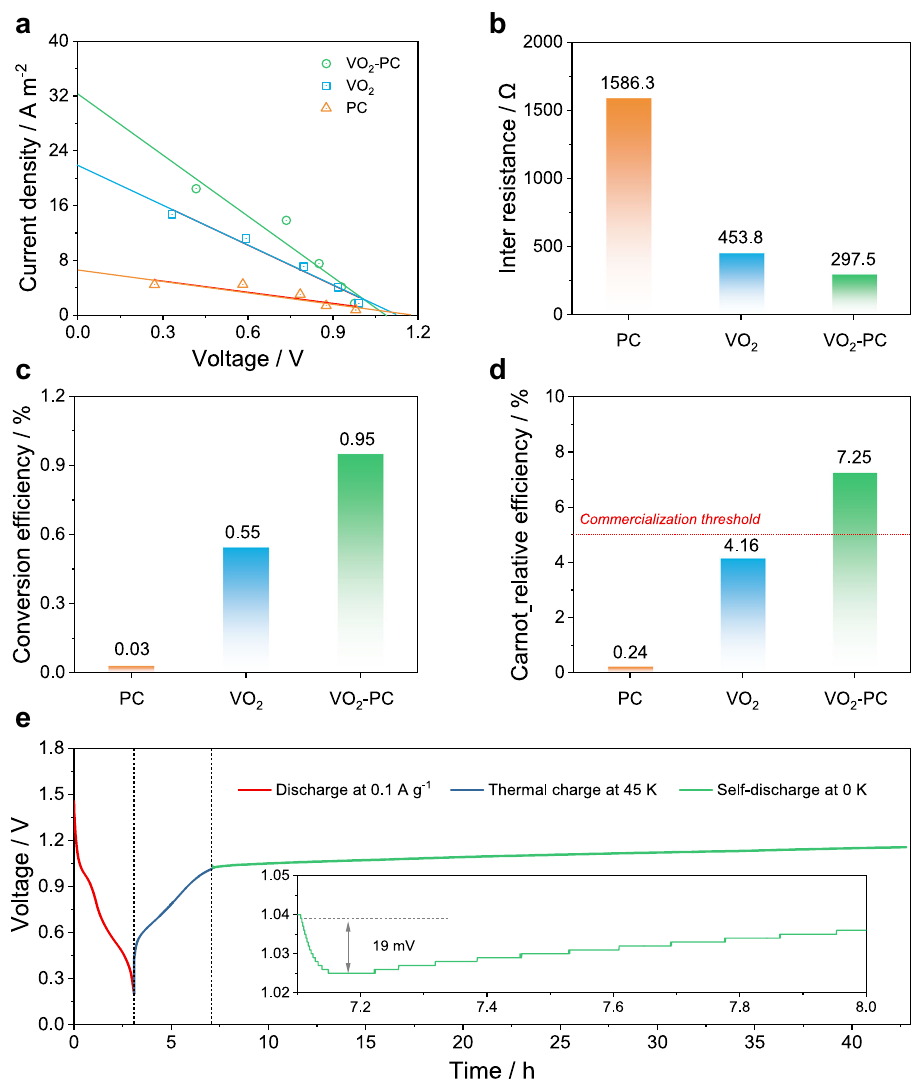
Fig. 3 Heat-to-electricity conversion of ZTCCs. a Current – voltage plot, b inter resistance, c conversion ef fi ciency, and d Carnot-relative ef fi ciency for PC, VO 2 , and VO 2 -PC, respectively. e Self-discharging curve after eliminating the temperature